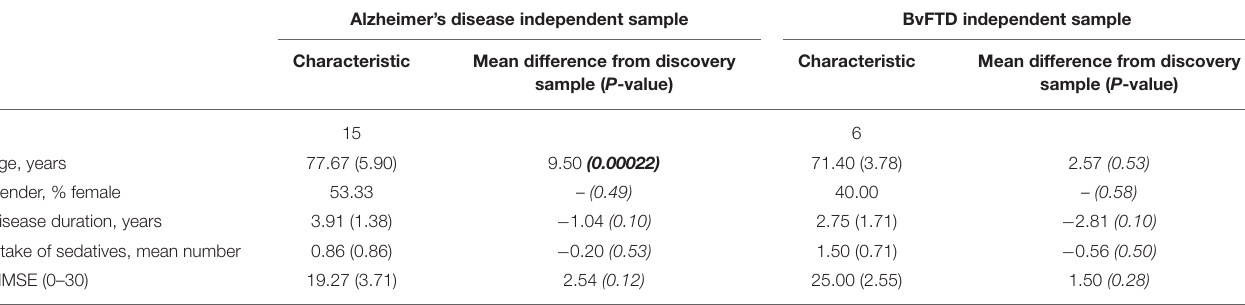
TABLE 7 | Demographics of Alzheimer’s disease and bvFTD independent